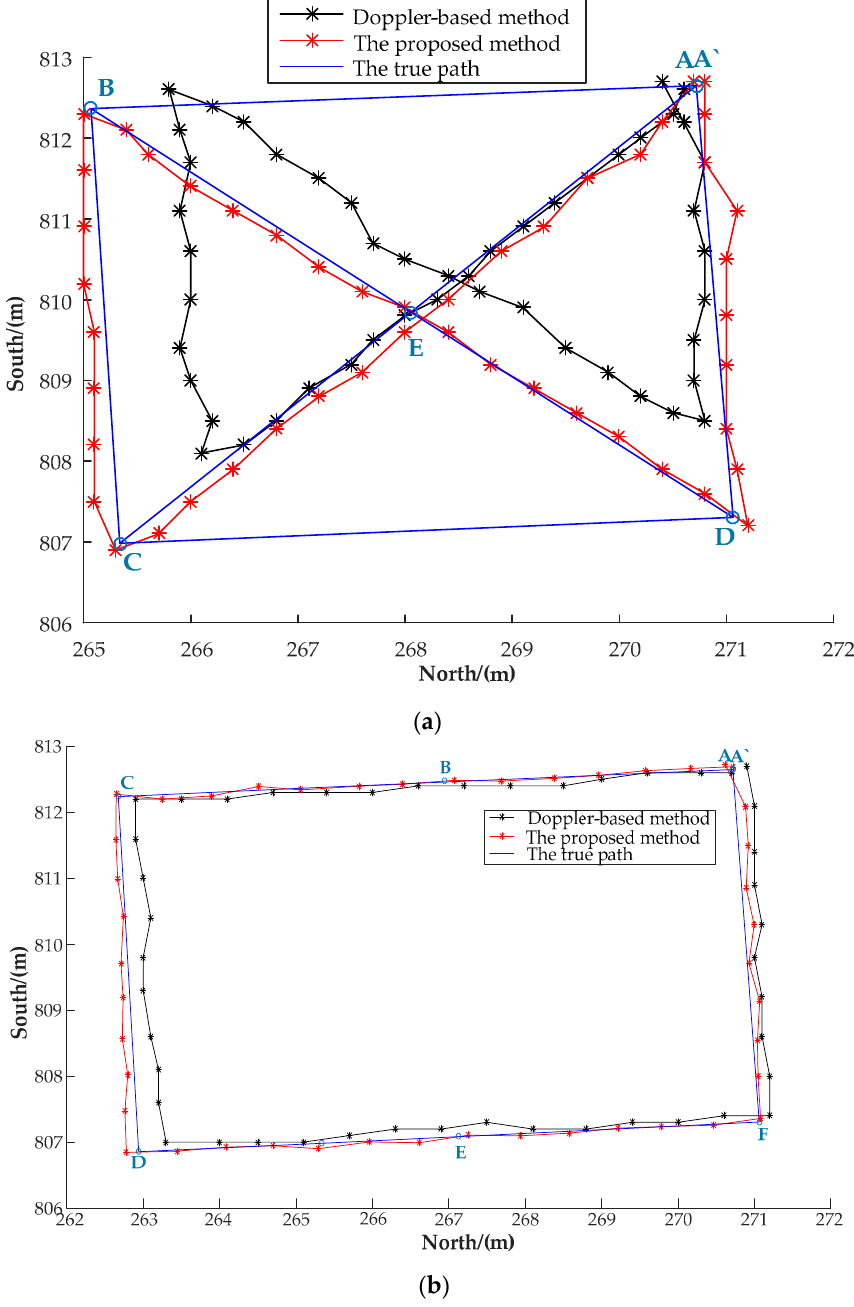
Figure 16. Evaluation of algorithms. ( a ) The trajectories of Person A. ( b ) The trajectories of Person B. Table 5. Comparison of location errors of Person A.